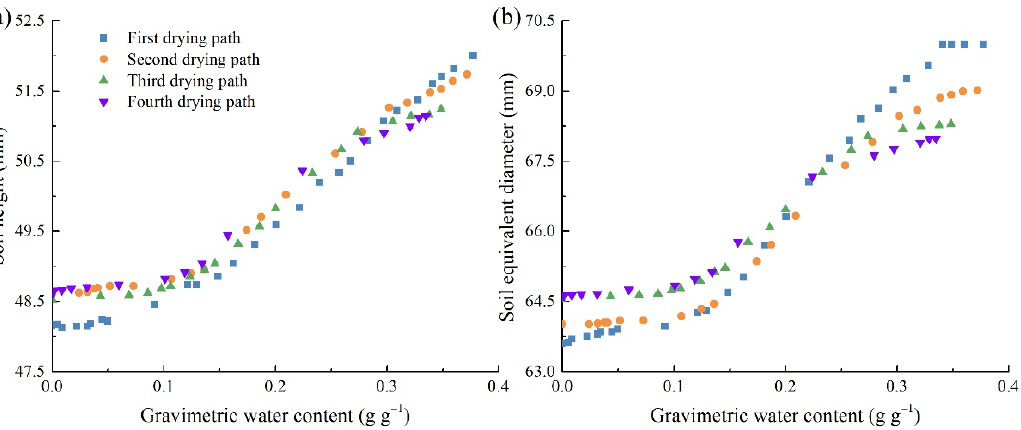
Figure 3. Dynamics of soil height and equivalent diameter during four drying paths. For brevity, only the data of replicate 1 are presented. ( a ) Soil height; ( b ) Soil equivalent diameter.